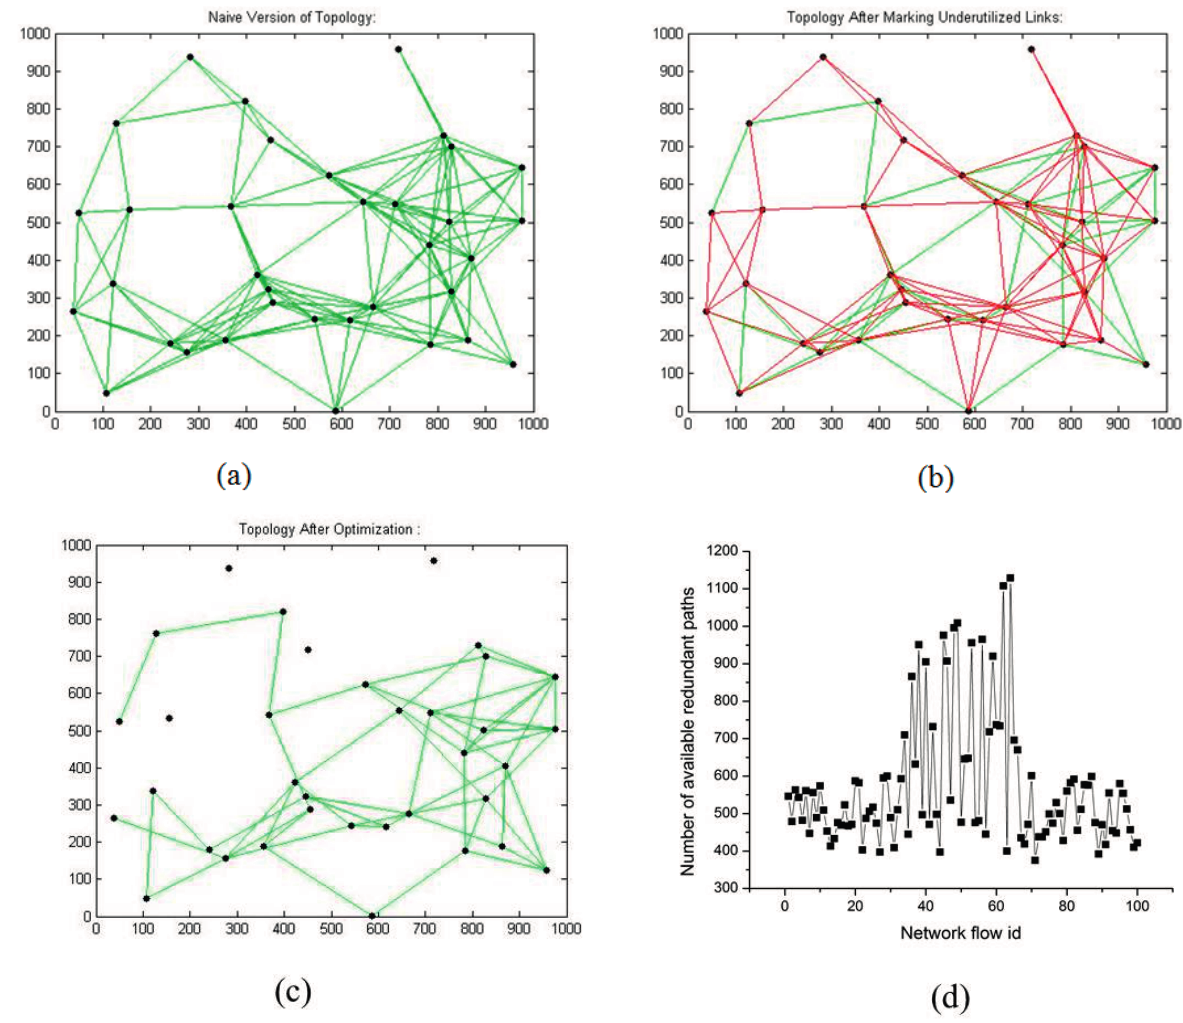
Figure 4. ( a ) 35 nodes’ naive topology; ( b ) 35 nodes’ marked topology; ( c ) 35 nodes’ optimized topology; ( d ) Path